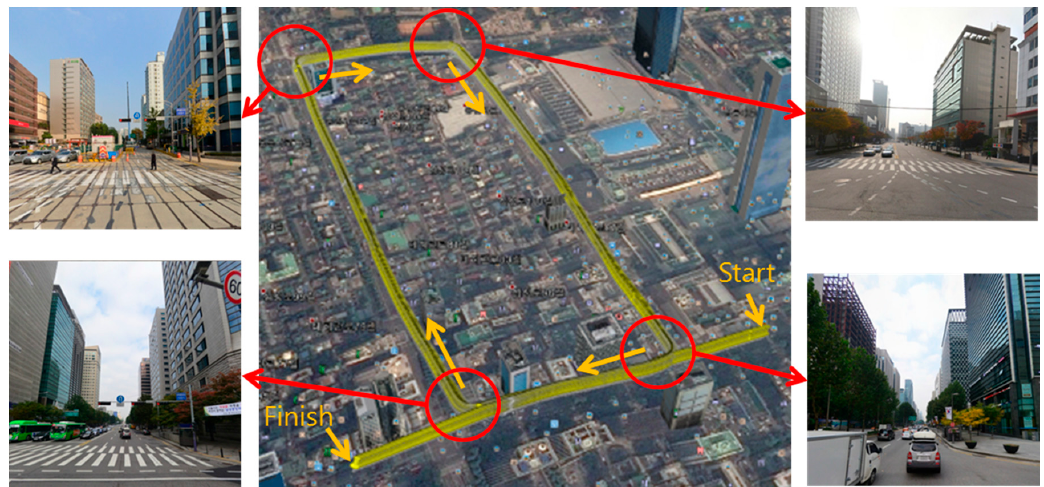
Figure 11. Vehicle trajectory and street view (four intersections).